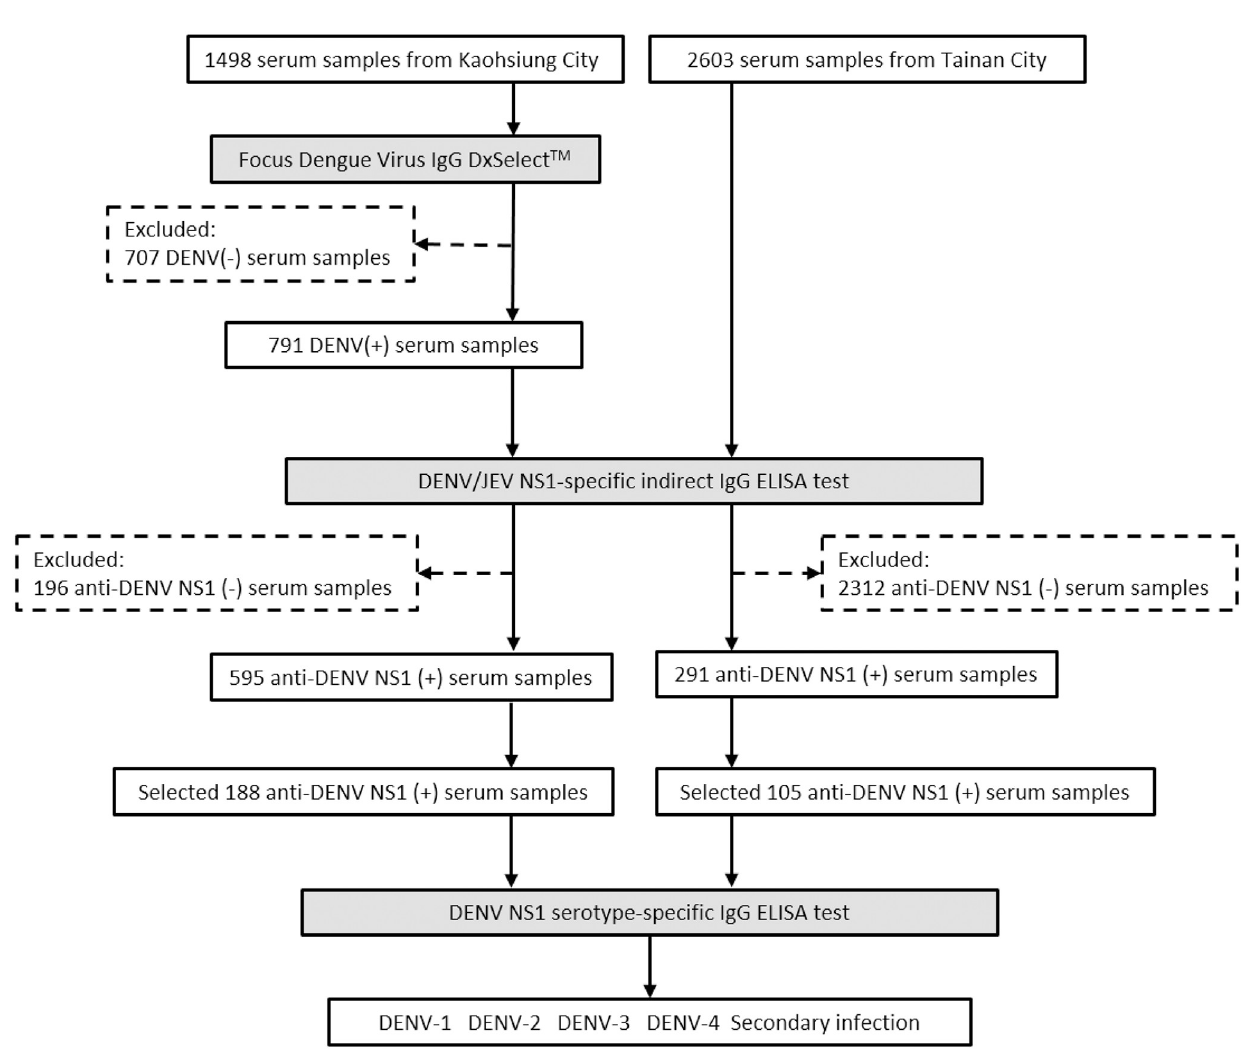
Fig 2. Flow chart of serosurvey of DENV-IgG among study subjects in Tainan City and Kaohsiung